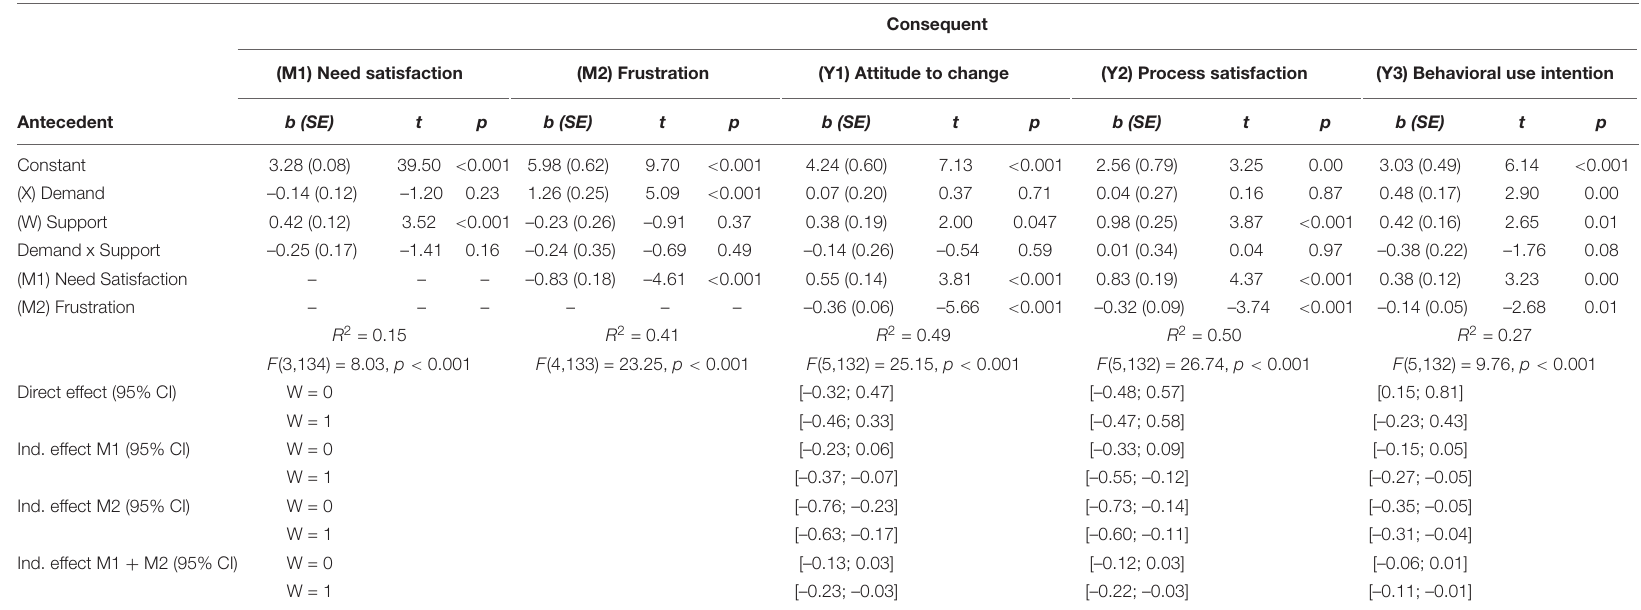
TABLE 7 | Regression coefficients, standard errors, and model summary information of the moderated mediation model – Study